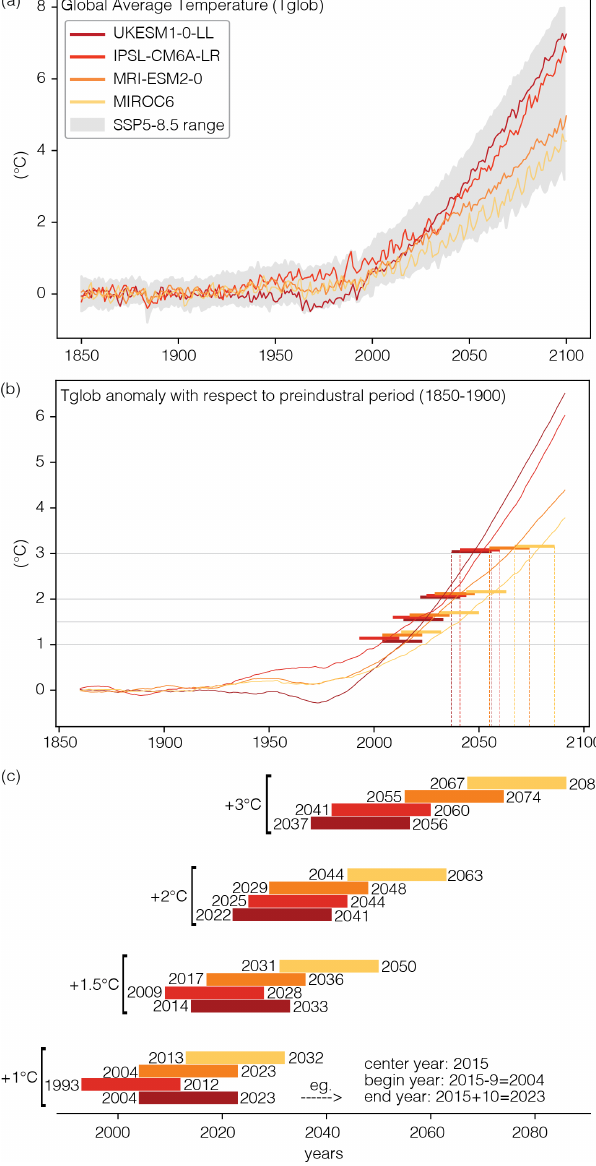
Figure 2. Global warming level calculation steps. (a) Global aver- age temperature for four example models under SSP5-8.5 scenario. Coloured lines refer to four models, and the shaded grey area refers to the spread of temperature variability in all SSP5-8.5 CMIP6 mod- els. (b) The 20-year running average of temperature anomaly with respect to the pre-industrial period. Horizontal bars represent warm- ing level periods ( + 1, + 1.5, + 2, + 3 ◦ C) for each model and are shifted vertically to ease understanding. (c) Zoomed version of bars (warming level periods) in panel (b) to show corresponding